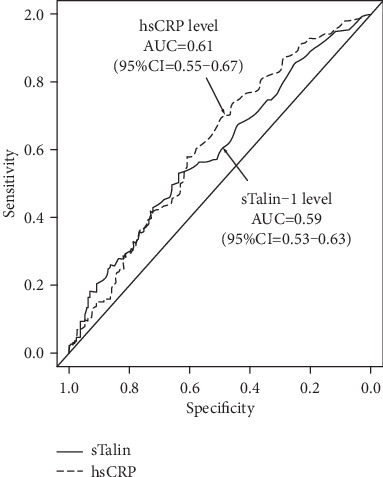
ROC curves of sTalin-1 and hsCRP levels for the diagnostic ability of CAD. Regarding the diagnostic abilities of sTalin-1 and hsCRP levels to predict CAD, the AUC for sTalin-1 levels was 0.59 (95%CI = 0.53–0.63), which did not significantly differ from the AUC for hsCRP levels (0.61; 95%CI = 0.55–0.67).